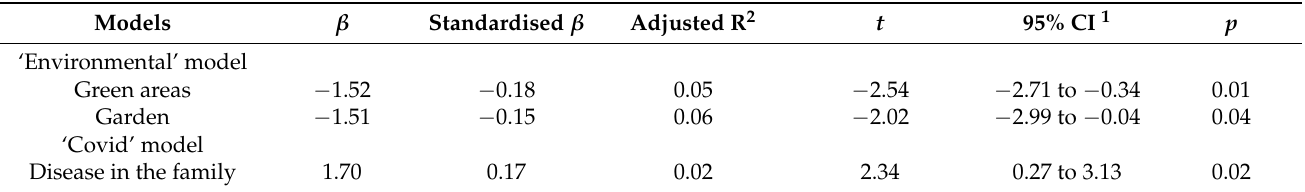
Table 3. Multiple linear regression results for the ‘Covid’ and ‘Environmental’ models with GDS during the pandemic (April, September and